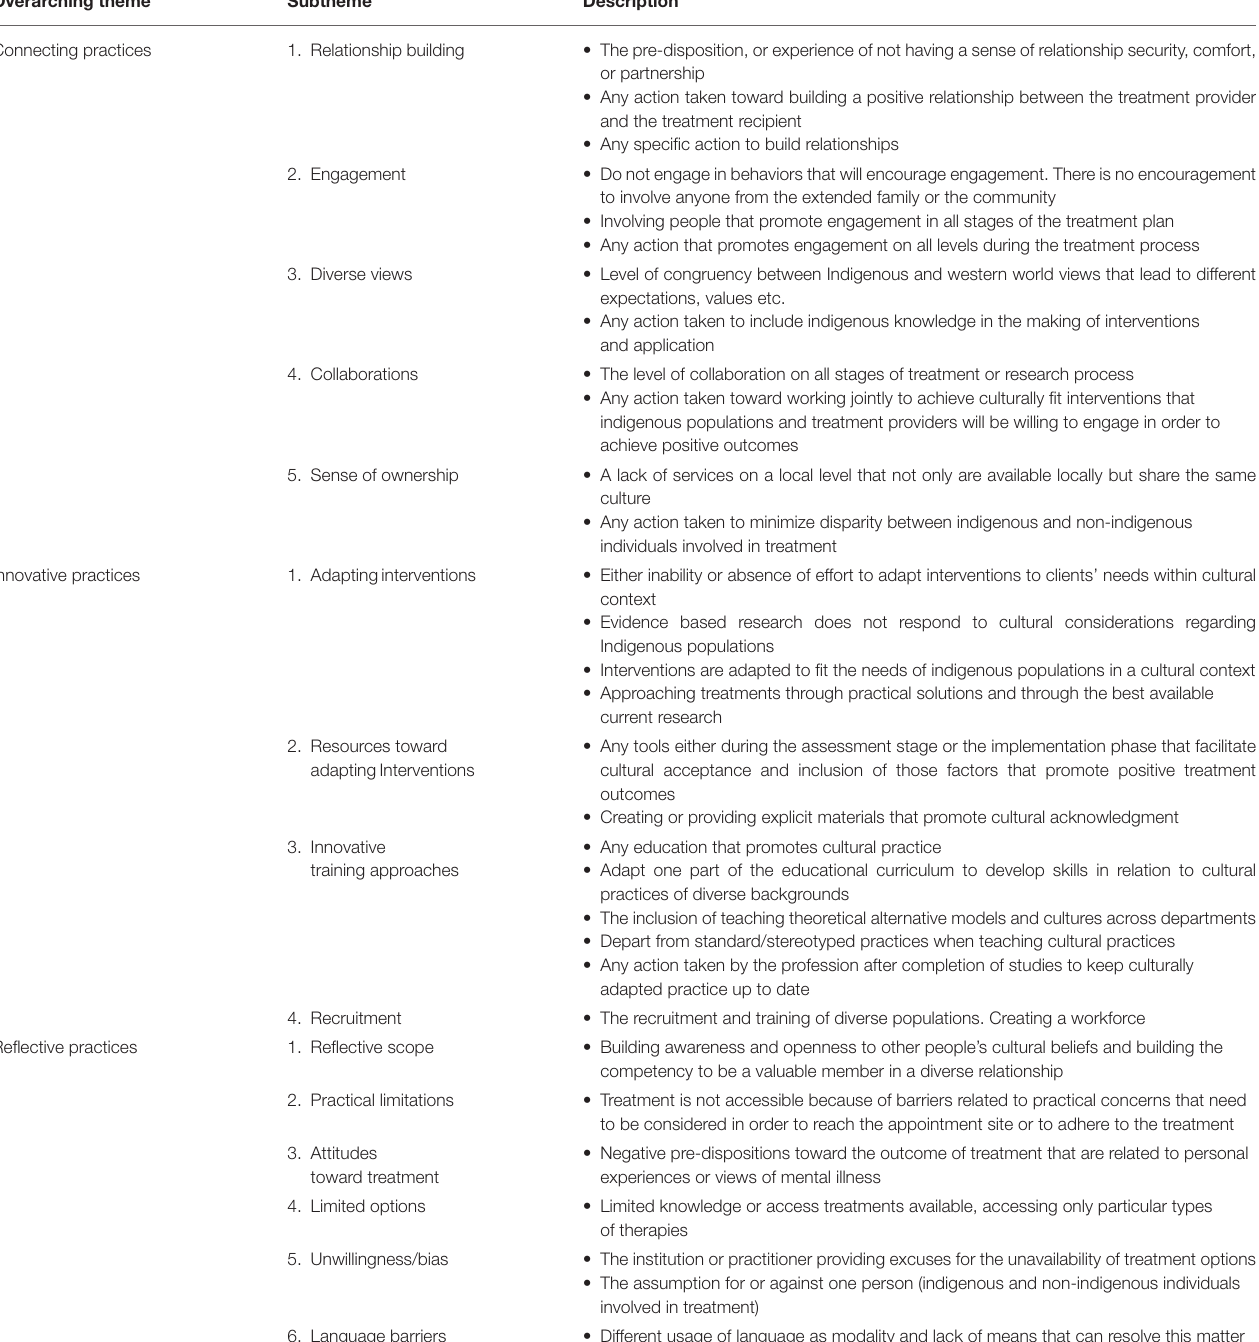
TABLE 3 | Summary of themes and subthemes that emerged from thematic analysis. Overarching